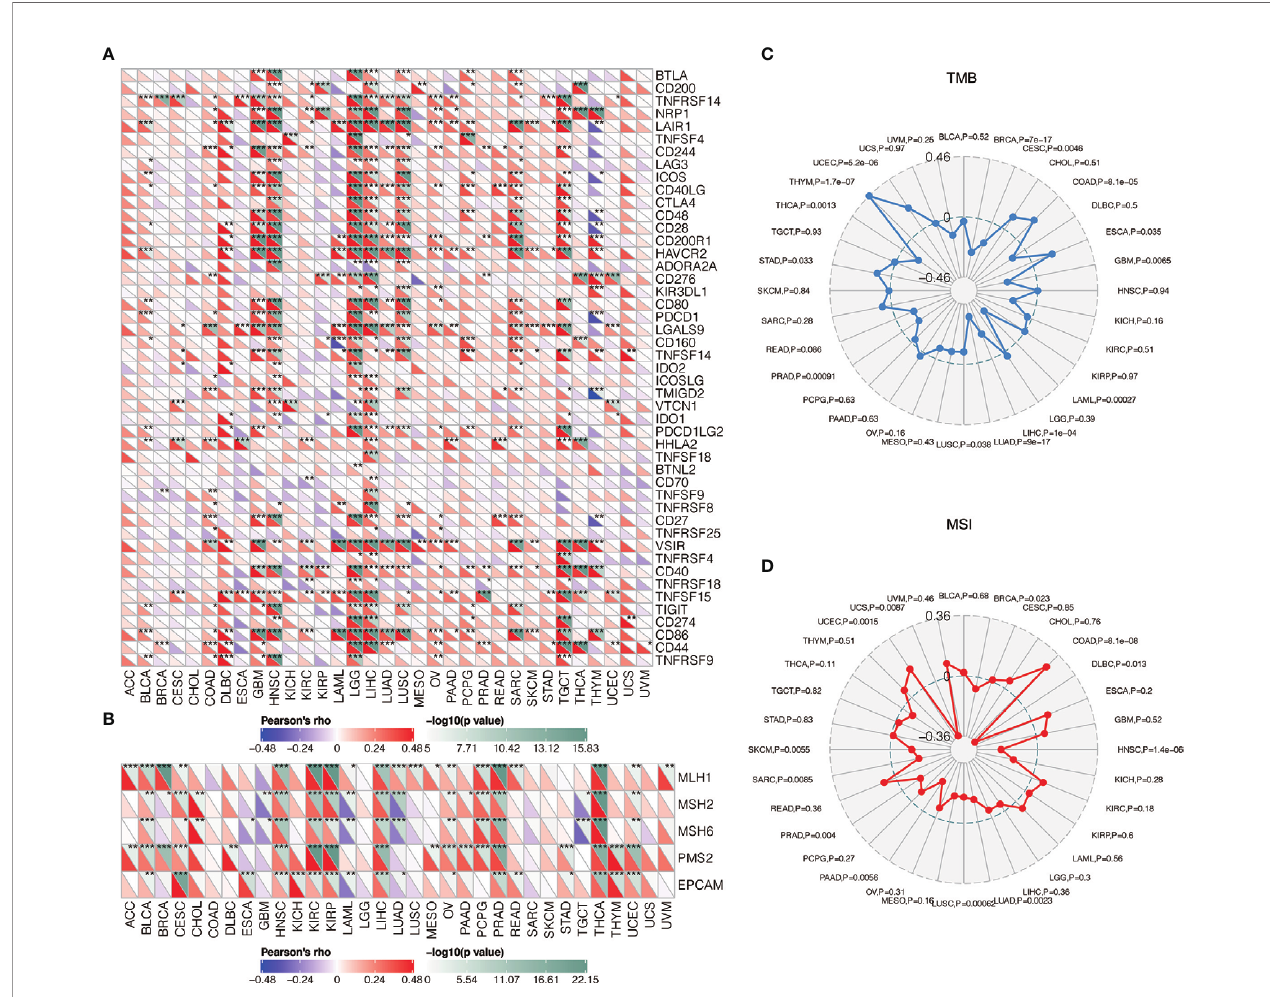
FIGURE 4 | Correlations between TNFSF13 and immunogenic factors as well as tumorigenic factors. (A) The correlations between TNFSF13 and immune checkpoints in different cancers (*P < 0.05, **P < 0.01, ***P < 0.001). (B) The correlations between TNFSF13 and signature genes for MMR in different cancers (*P < 0.05, **P < 0.01, ***P < 0.001). (C) The correlations of TNFSF13 expression and TMB in different cancers. (D) The correlations of TNFSF13 expression and MSI in different